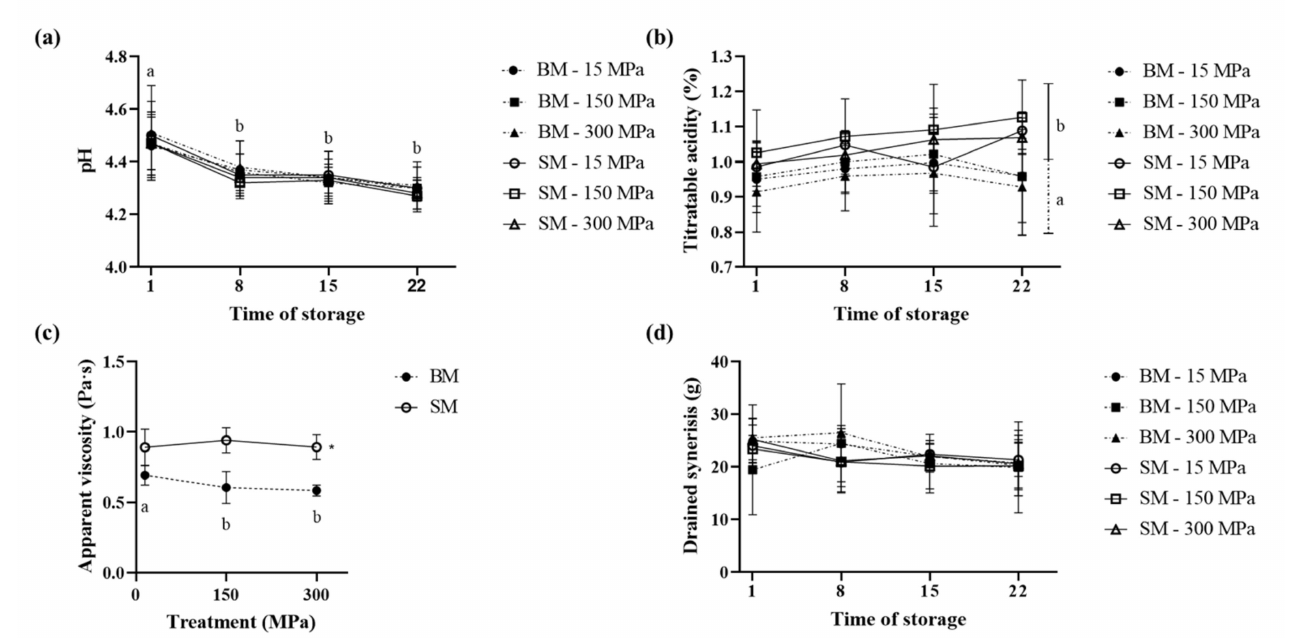
Figure 5. Evolution of physico-chemical properties (( a ) pH, ( b ) titratable acidity, ( c ) apparent viscosity, and ( d ) drained syneresis) for stirred buttermilk (BM stippled line) and skimmed milk (SM. plain line) yogurts as a function of storage time (1, 8, 15, and 22 days) and pressure levels (15, 150, and 300